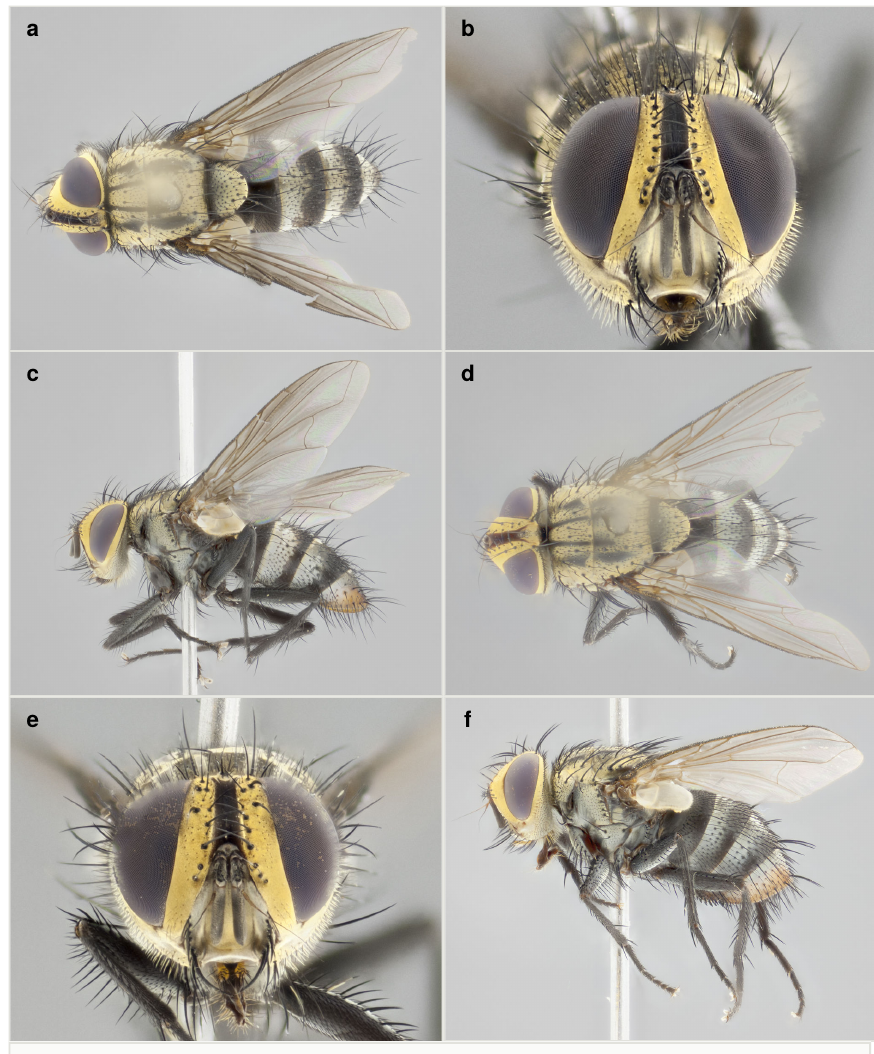
Vibrissina randyjonesi sp. n. a–c : holotype male, voucher code: DHJPAR0052639; d–f